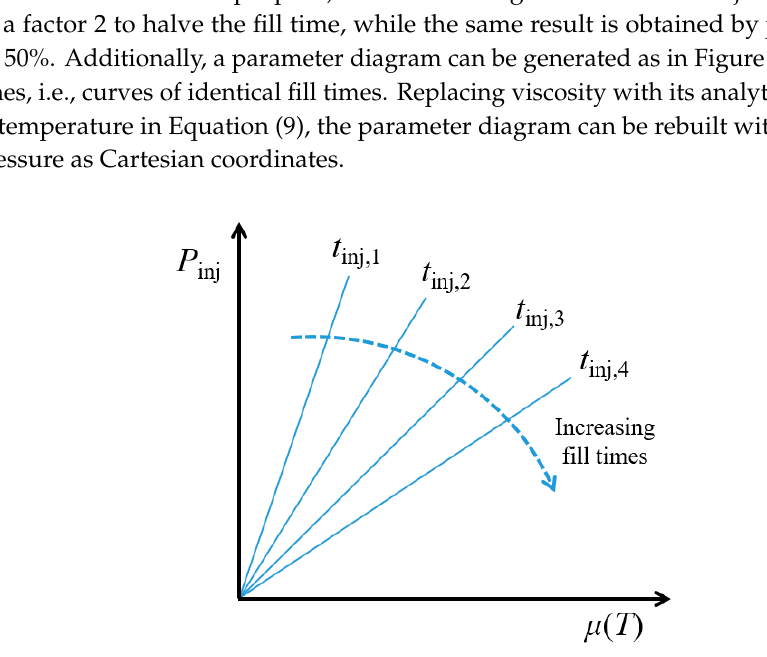
Figure 7. Example of parameter diagram with isochrones of fill times. Each point along the same isochrone line is associated with the same fill time (lower slopes imply higher fill times).